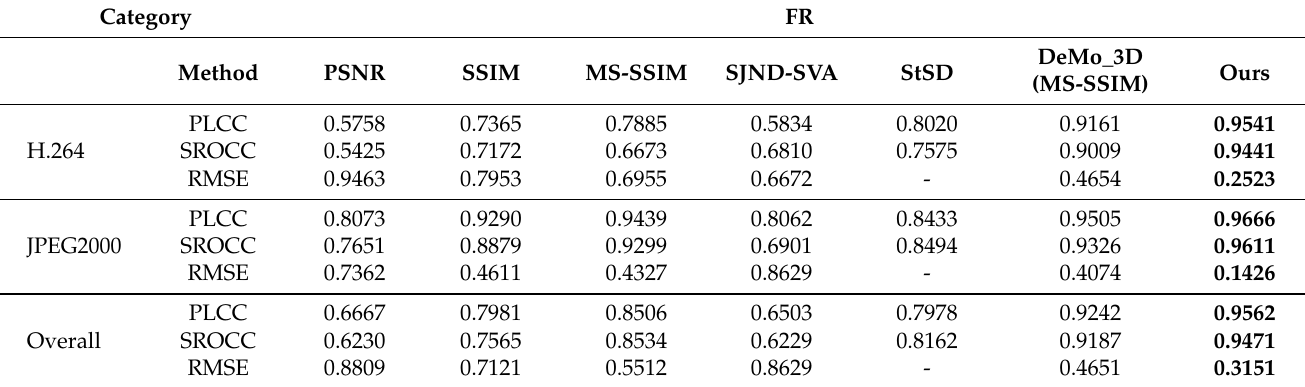
Table 3. Performance comparison of FR methods on QI-SVQA database. The best results are in bold.